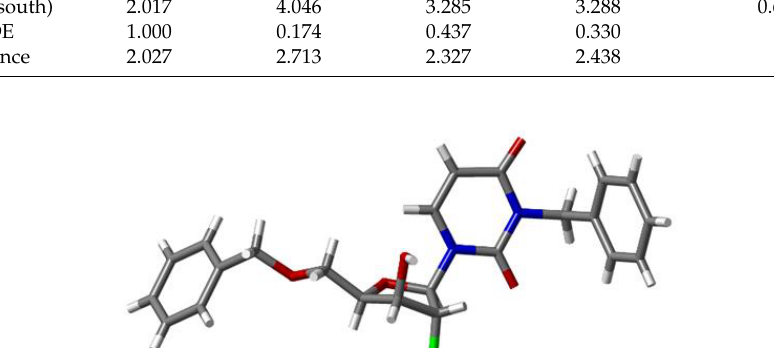
Table 2. Calculated and experimental distance values for conformers A1–D2 of compound 12 . Distances are shown in Å. Experimental values were recorded in CDCl 3.